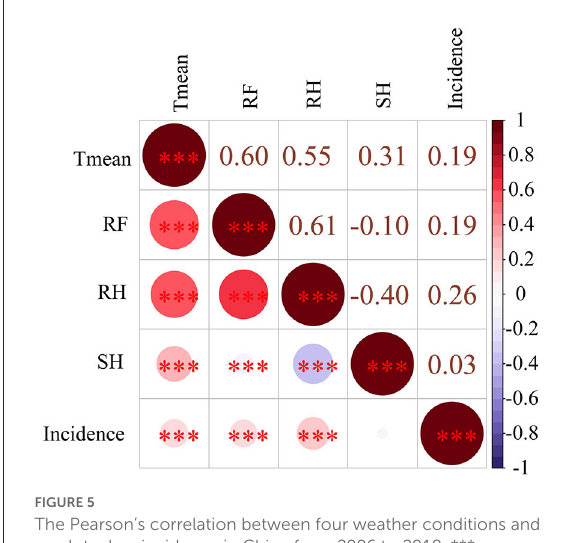
FIGURE5 The Pearson’s correlation between four weather conditions and scrub typhus incidence in China from 2006 to 2018. ***means ≤ 0.001; **means 0.01 ≥ p > 0.001; *means 0.05 ≥ p > 0.01. Mean temperature (Tmean), rainfall (RF), sunshine hours (SH), and relative humidity (RH).